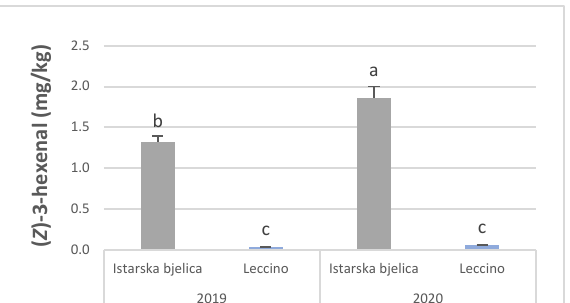
Figure 4. Multiple comparisons of the effects of cultivar (Cv.) (Istarska bjelica, Leccino) and year (Y) (2019, 2020) on the concentration of ( Z )-3-hexenal. Different superscript lowercase letters represent statistically significant differences between the mean values at p < 0.05 that were obtained by a three-way ANOVA and Tukey’s test.